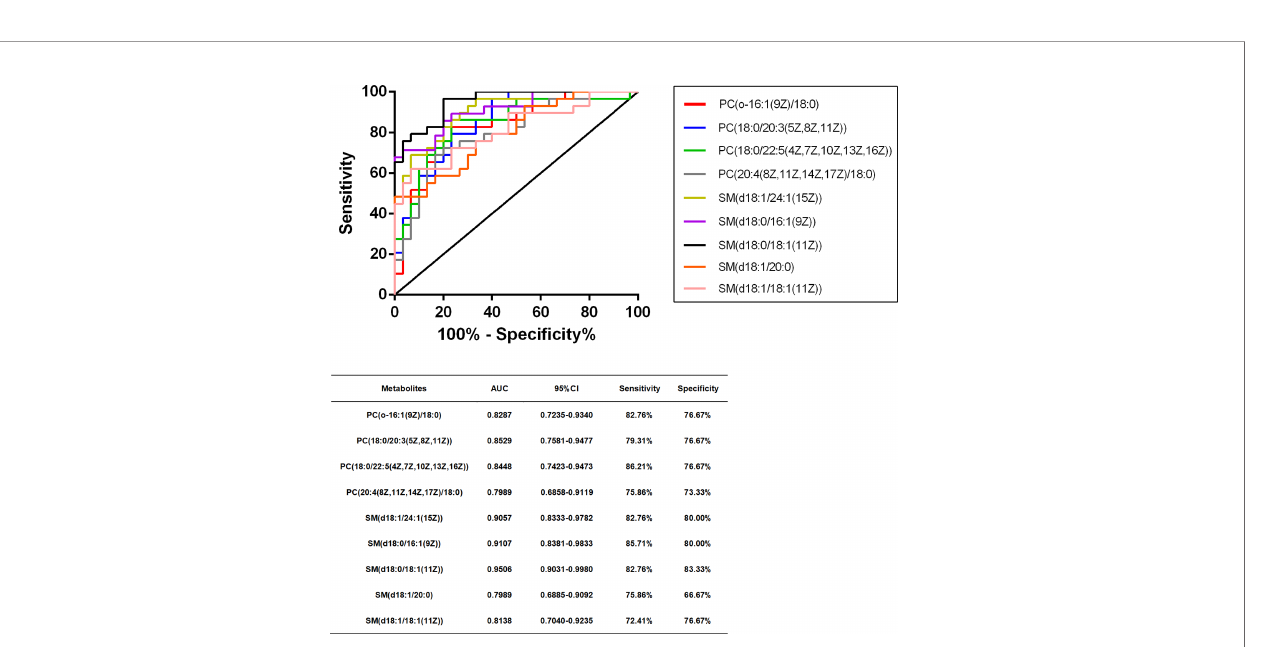
FIGURE 6 | ROC curves of selected differential